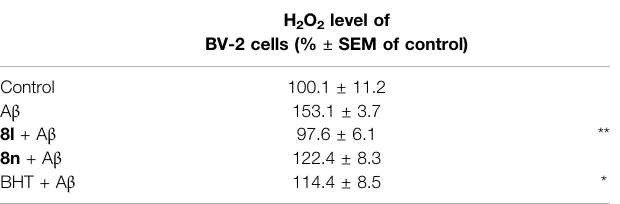
TABLE 4 | Extracellular H 2 O 2 produced by the BV-2 cells treated by compounds 8l and 8n .